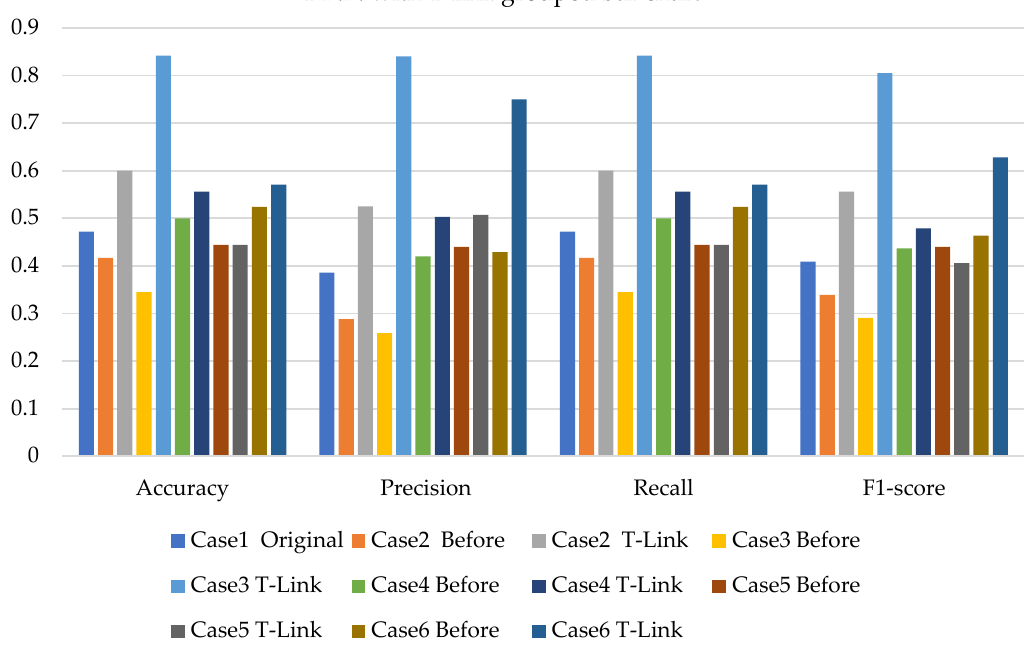
Figure 12. Simulation performance of k-NN classification with T-link.